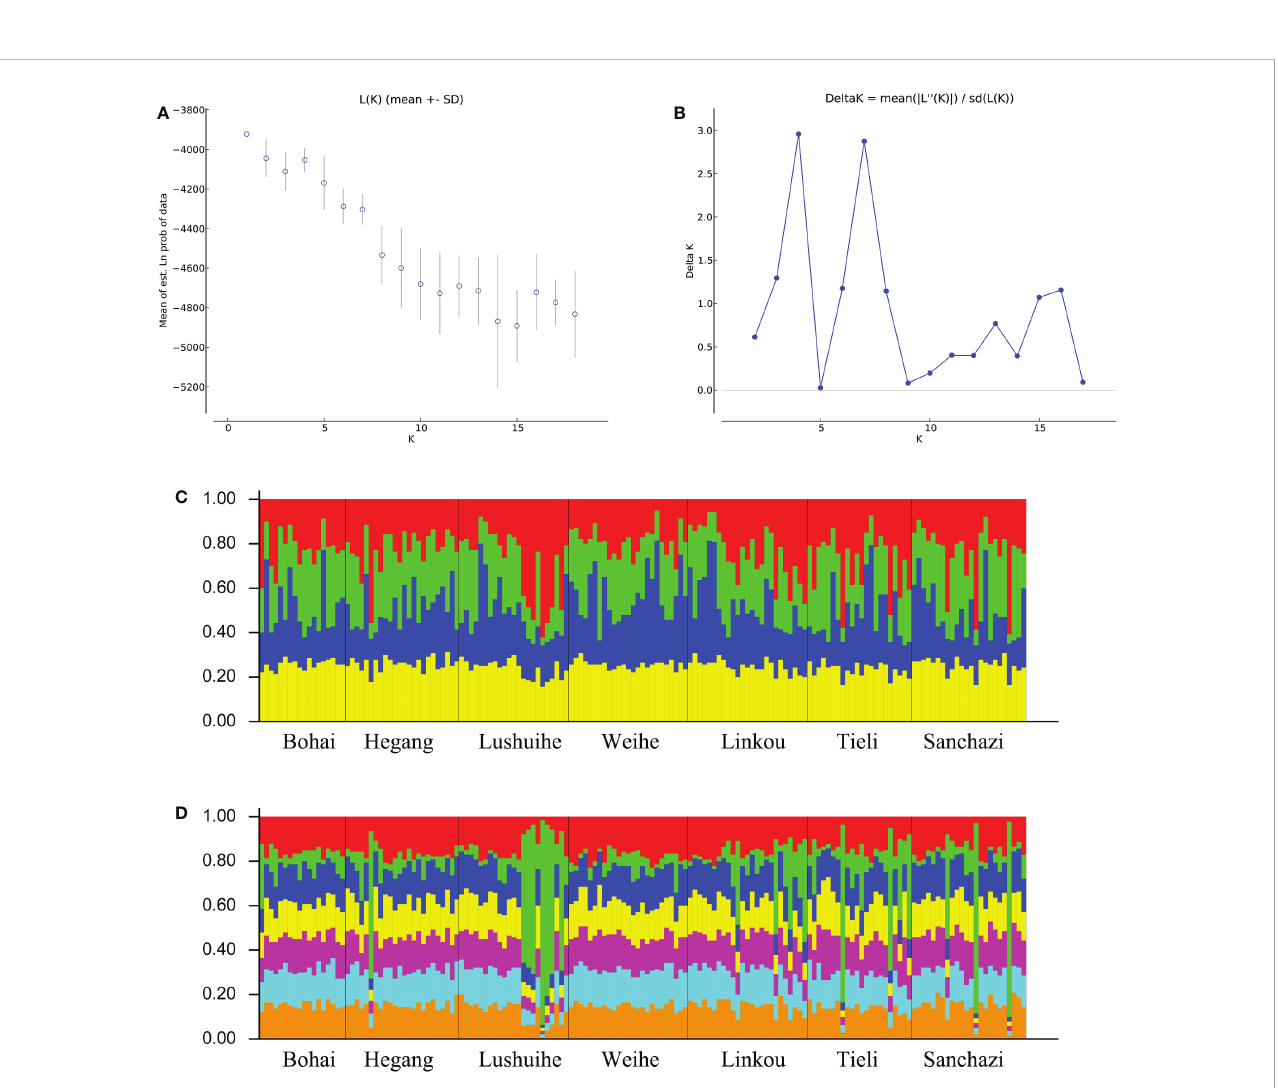
FIGURE 6 STRUCTURE analysis of Korean pine population. (A) Calculation of population structure using Mean LnP (K). (B) Relations between the optional number of cluster K and Delta K (C) Genetic structure map of 7 populations of Korean pine based on STRUCTURE analysis (K = 4). (D) Genetic structure map of 7 populations of Korean pine based on STRUCTURE analysis (K = 7).